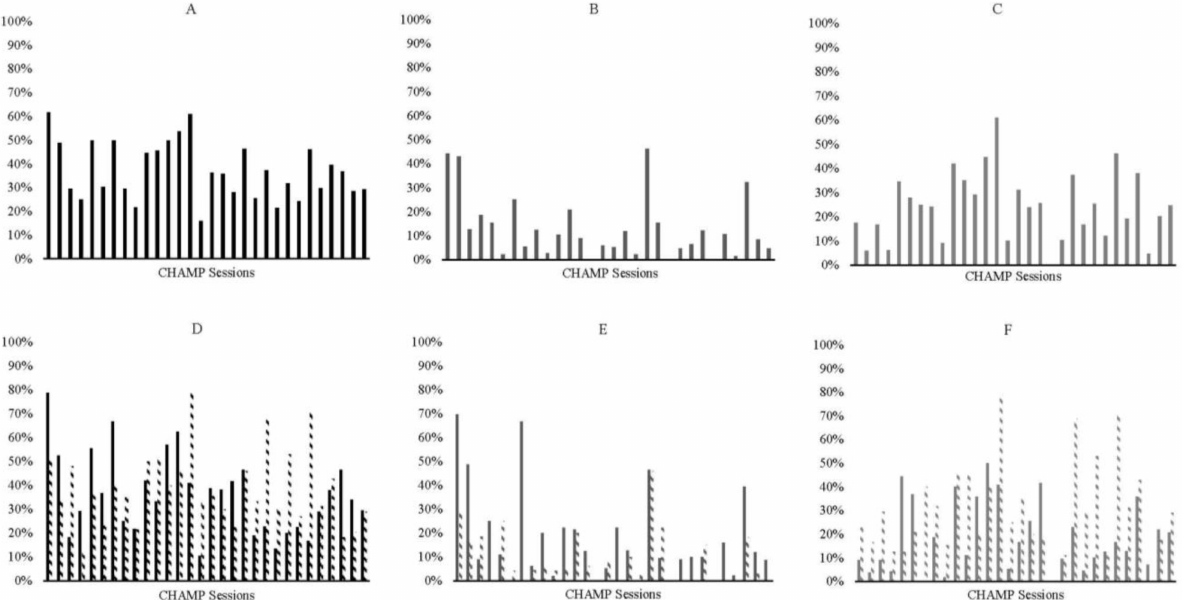
Figure 2. Graphs representing all boys’ engagement across the 30-intervention sessions. In all plots, percentage of engagement is plotted on the y-axis and session number if on the x-axis. Plots include ( A ) all skills, ( B ) locomotor skills, ( C ) ball skills, ( D ) all skills for children with below average initial skills and average and above average initial skills, ( E ) locomotor skills for children with below average initial skills and average and above average initial skills, and ( F ) ball skills for children with below average initial skills and average and above average initial skills. For graphs ( D – F) , children with below average initial skills are plotted in solid bars and children in average & above average initial are plotted in dashed